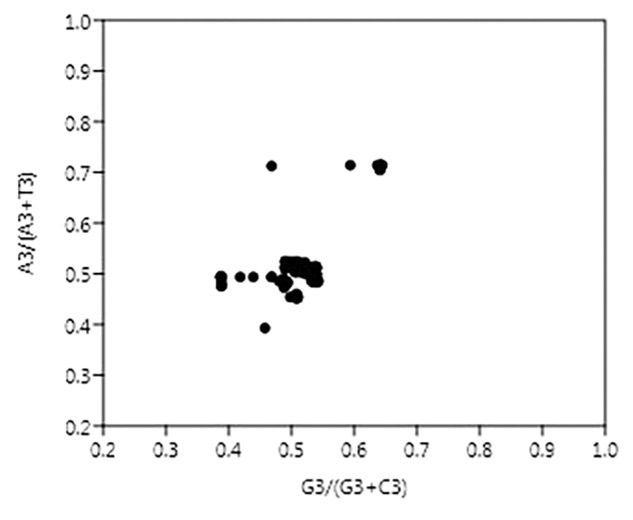
Parity plot showing the presence of AT bias [A3%/(A3% + T3%)] and GC bias [G3%/(G3% + C3%)]. The center of the plot, where value of both the coordinates is 0.5, indicates the place where there is no bias in mutation or selection rates.